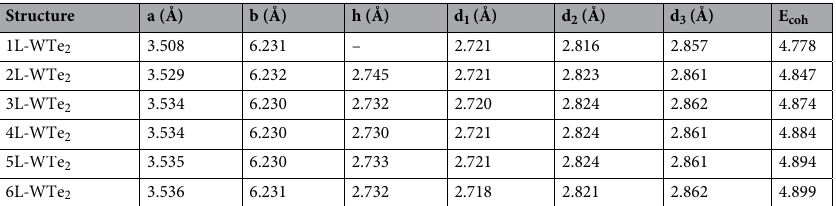
Table 1. Structural parameters calculated within PBE+SOC for 1L, 2L, 3L, 4L, 5L and 6L 1T ′ WTe 2 : Lattice constants in the ( xy )-plane, | � a | = a ( (cid:31) x ) and | � b | = b ( (cid:31) y ); interlayer (van der Waals) distance between successive WTe 2 layers, h ; bond lengths between neighboring W and Te atoms, d 1 (W-Te(1)), d 2 (W-Te(2)), and between W atoms d 3 (W-W); cohesive energy per atom, E coh (eV/atom).